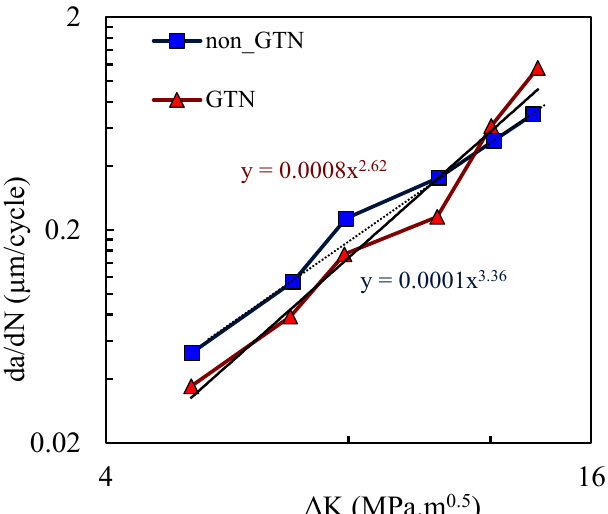
Figure 3. da/dN - Δ K curves in log-log scale (plane strain; R = 0.1; f 0 = 0.01; q 1 = 1.5; q 2 = 1 and q 3 = 2.25, nucleation and coalescence are disabled). The Paris–Erdogan law parameters are shown on the equations related to the trendlines.